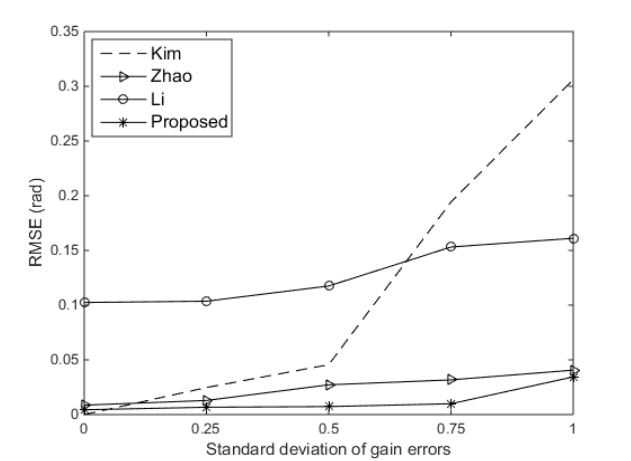
Figure 6. Root mean square error (RMSE) versus the standard deviation of gain